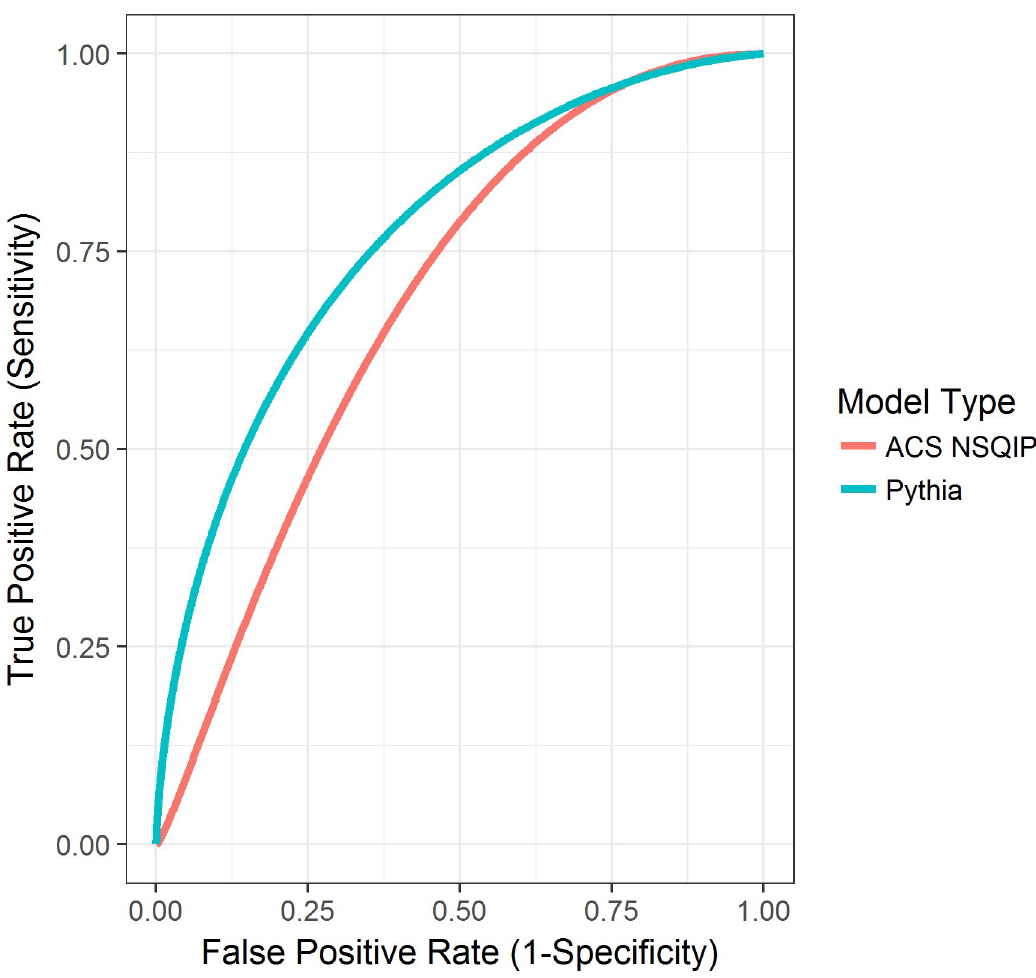
Fig 5. Plotted AUCs for 30-day postoperative mortality in Pythia versus ACS NSQIP. ACS, American College of Surgeons; AUC, area under the receiver operator characteristic curve; NSQIP, National Surgical Quality Improvement Program.